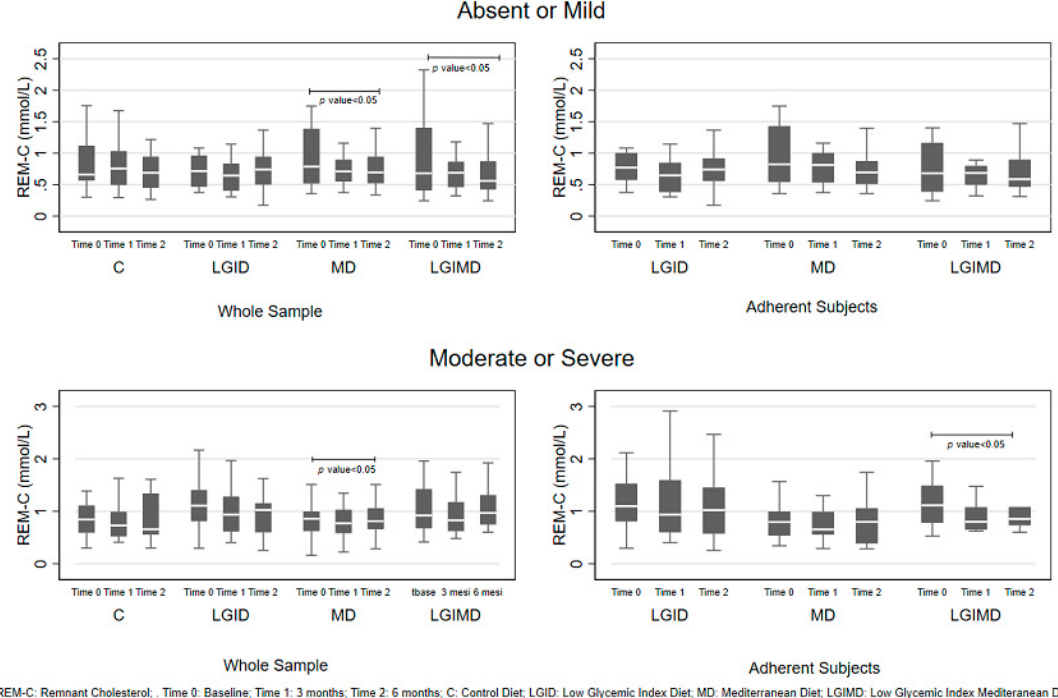
Figure 1. Remnant cholesterol level by non-alcoholic fatty liver disease severity, diet, and time. Results from Repeated Measures Analysis of Variance for Diet and Time are shown in Table 3.